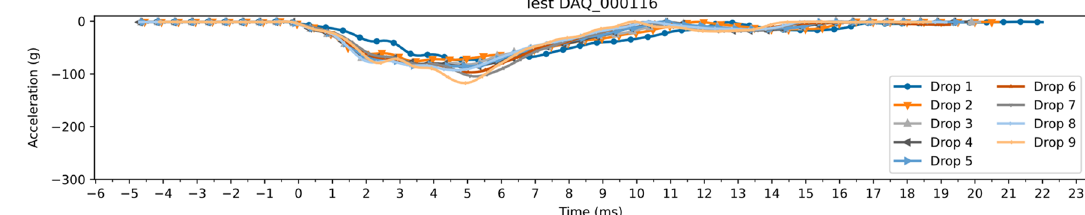
Fig. 6 Accelerations measured during nine consecutive drops with P1 (400 g / 200 × 100 × 31 mm / 3–3-3 wrapping pattern)